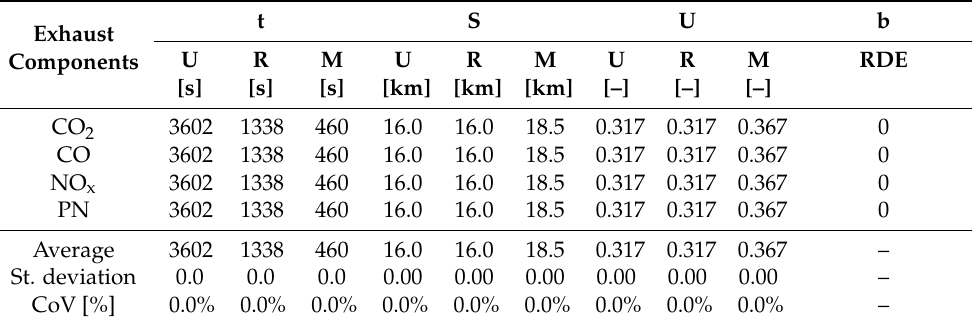
Table A6. Road emissions for the RDE test (assuming variable exhaust emission intensity)—output data obtained from the algorithm and the proposed values for the generalized test (Vehicle B).